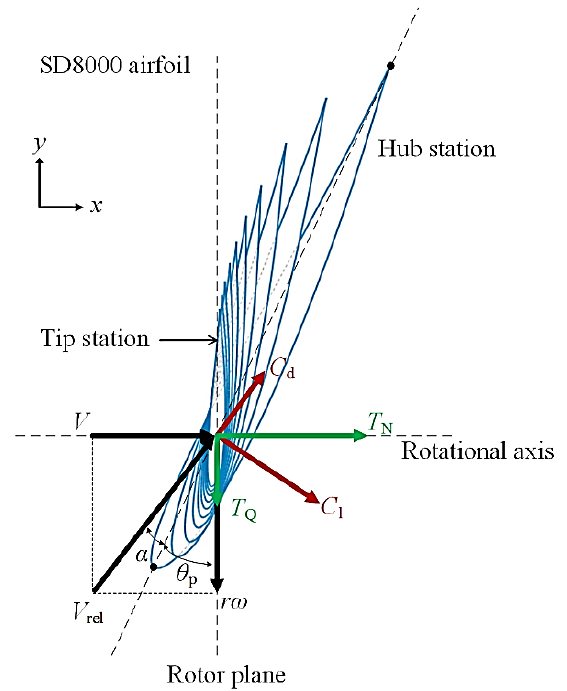
Figure 2. Diagram of velocities, angles and forces on one